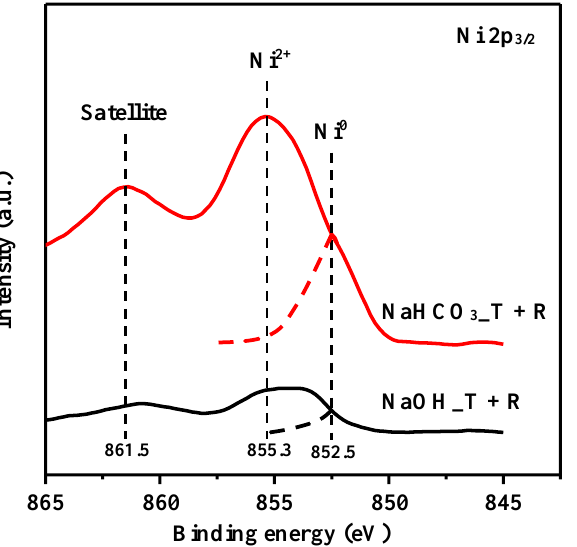
Figure 9. Ni 2p 3/2 XPS spectra of the reduced NaOH_T + R and NaHCO 3 _T + R catalysts. Table 2. The quantitative elements and surface compositions of the reduced NaOH_T + R and NaHCO 3 _T + R catalysts on the 500 °C calcined LDH thin films by XPS analysis. NaOH_T + R Element Element